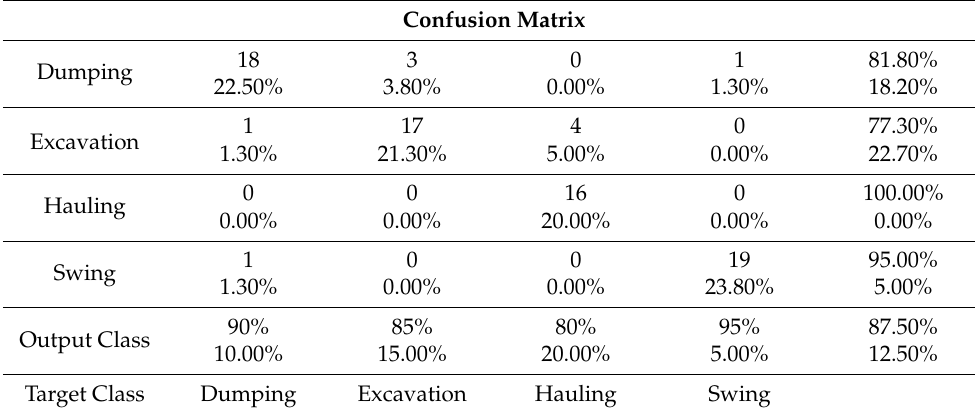
Table 5. Confusion matrix of the test